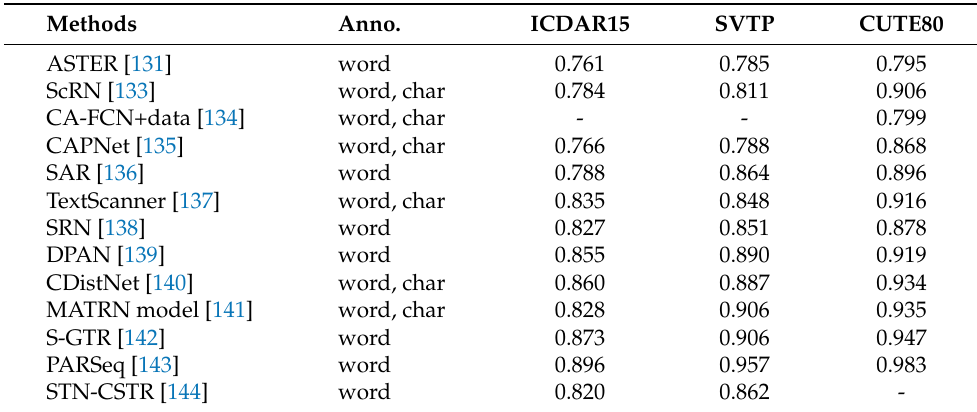
Table 8. Accuracy results of text recognition methods on ICDAR15, SVT Perspective and CUTE80. “Anno.” is short for required